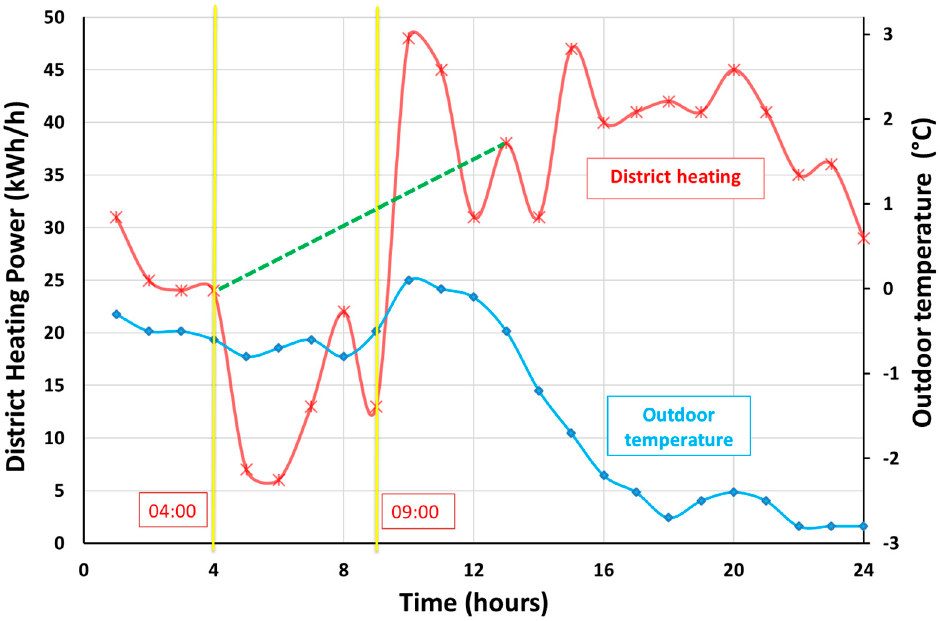
Figure 6. Delivered district heating (DH) power for the building and the outdoor temperature both before and during the temperature decay.